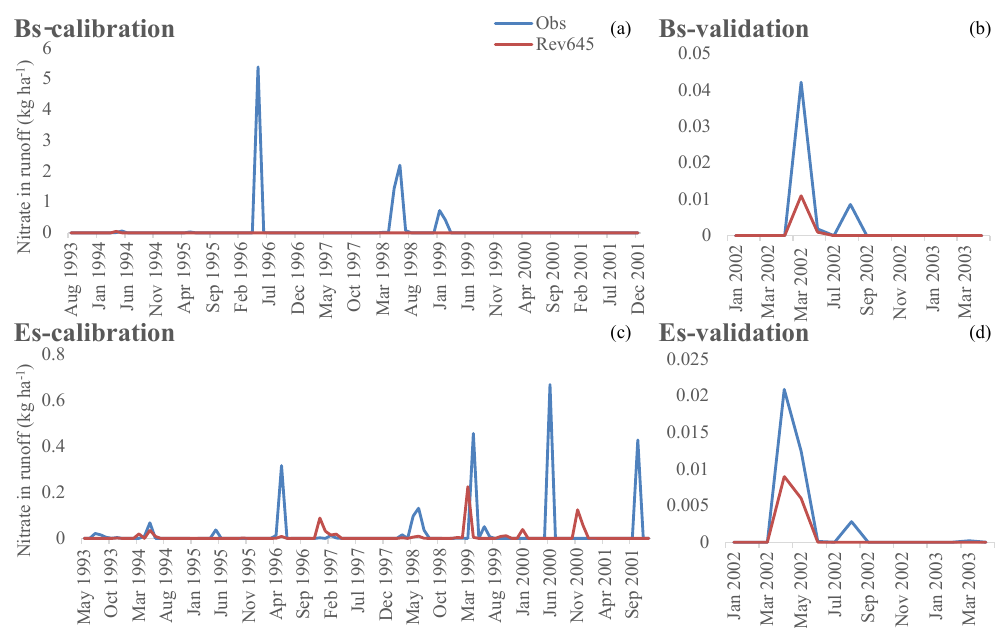
Figure 7. Calibration and validation results for monthly nitrate-nitrogen losses in surface runoff at sites Bs (a, b) and Es (c, d) . Obs and Rev. 645 represent Observed and Revision 645,